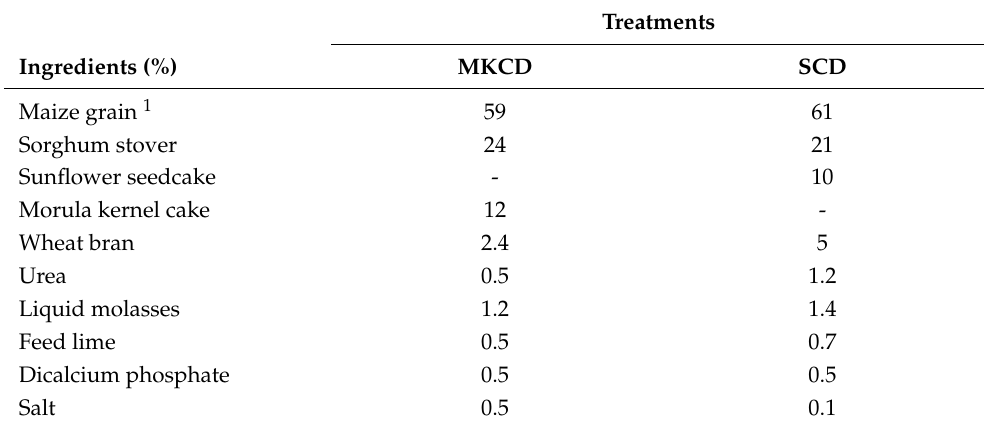
Table 1. Ingredients used in experimental diets.